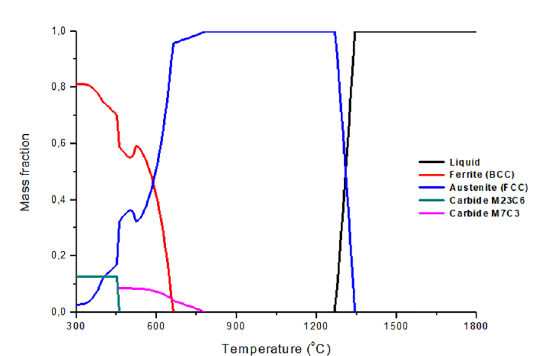
Figure 2. Mass fraction diagram of the 20% manganese steel. Source: author The mass fraction diagram of the 22% manganese steel